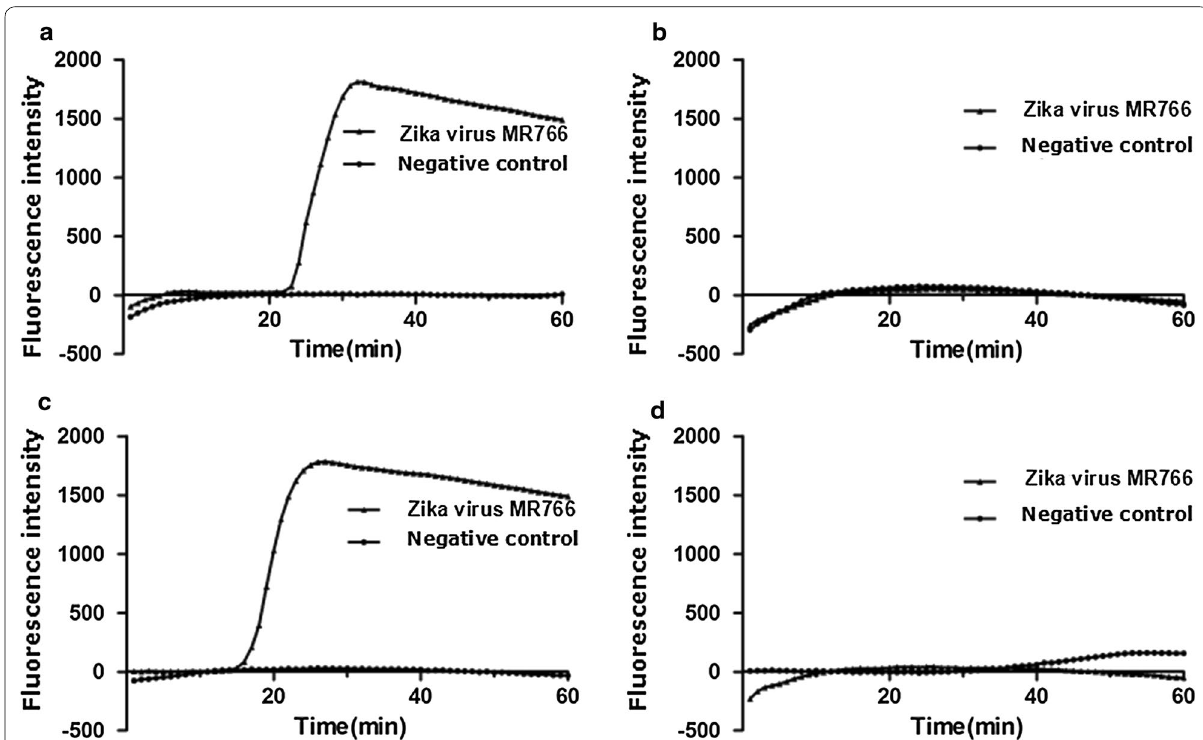
Fig. 3 The primer of LAMP screening test in this study. a Real‑amp with loop primers (NS‑1); b real‑amp with loop primers (NS5‑2); c real‑amp with loop primers (NS5‑3); d real‑amp with loop primers